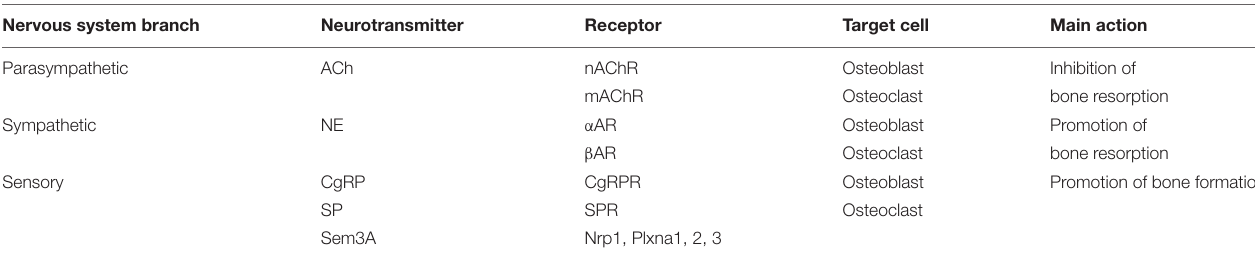
TABLE 1 | Peripheral nervous system to bone communication. Nervous system